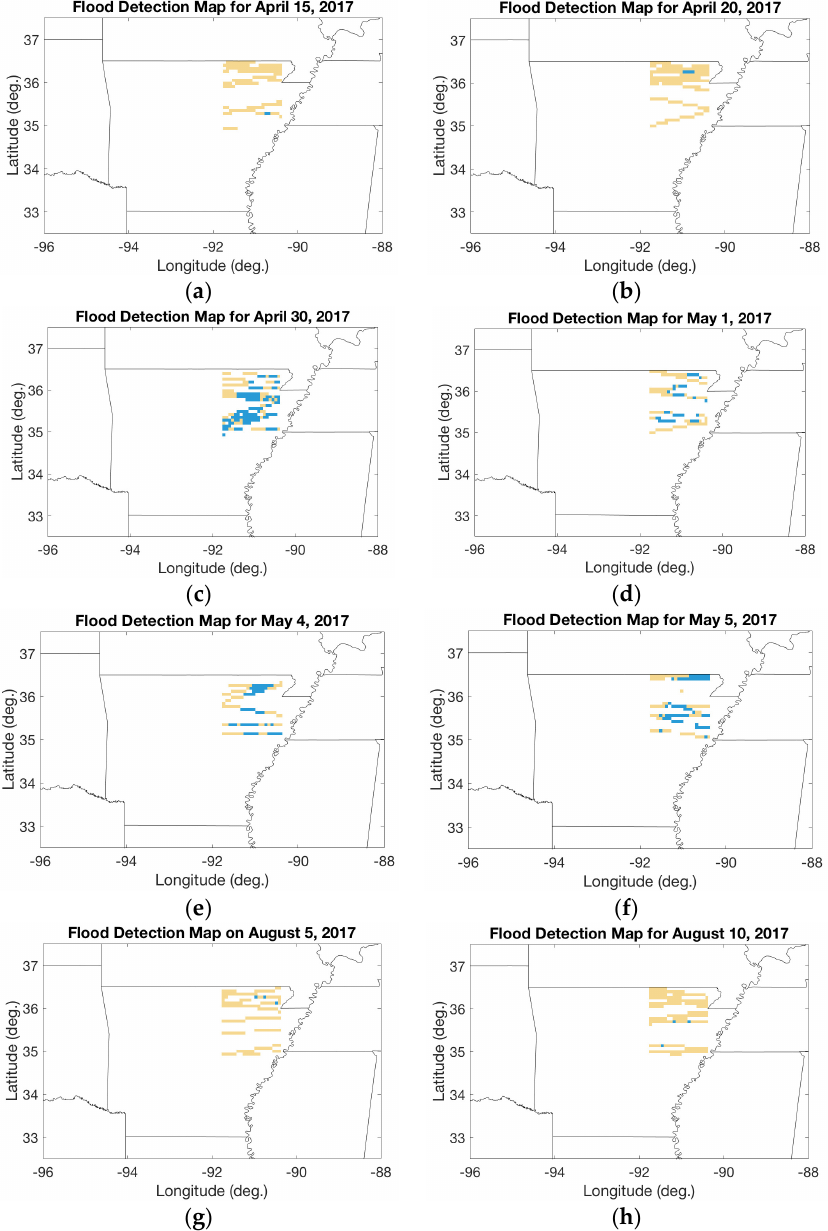
Figure 13. Examples of flood detection maps for the area under study on ( a ) 15 April 2017, ( b ) 20 April 2017 before the Midwest spring floods occurred, then ( c ) 30 April 2017, ( d ) 1 May 2017, ( e ) 4 May 2017 and ( f ) 5 May 2017 during the floods, and ( g ) 5 August 2017 and ( h ) 10 August 2017 months after the floods occurred. Note that flooded pixels are shown in blue, while non-flooded pixels are displayed in pale orange.